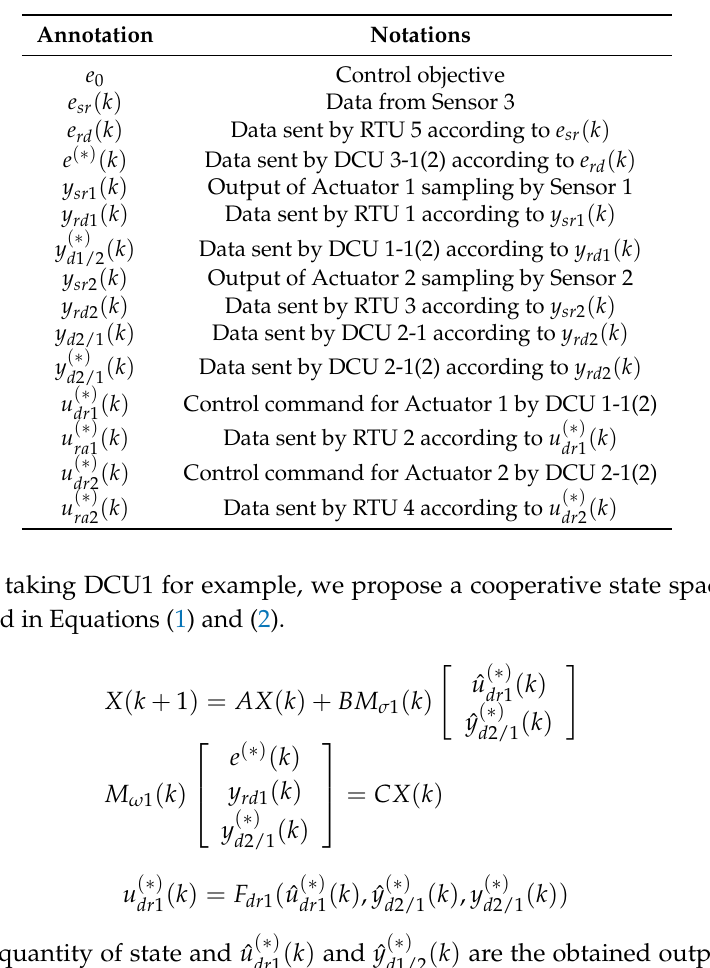
Table 1. Notations of Figure